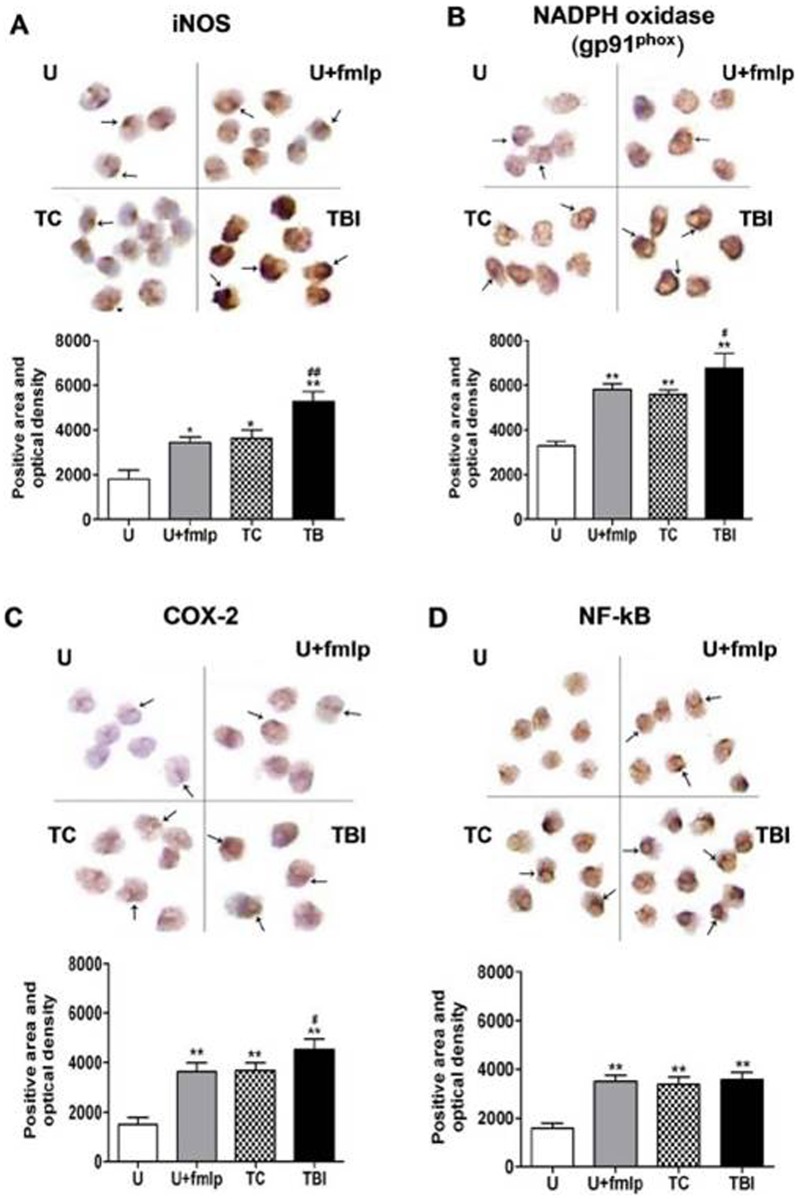
Expression of iNOS, NF-kB, COX-2 and NADPH oxidase (gp91phox) in leukocytes on blood smears.From uninjured (U), uninjured with fMLP activation (U+fMLP) and trauma controls (TC) and traumatic brain injury (TBI) subjects, expression of iNOS, NF-κB, COX-2 and NADPH oxidase (gp91phox) in leukocytes subjects at 24 h after injury are determined with immunostaining on blood smears. Blood smears were immunostained for the NF-κB (nucleus) and the oxidative enzymes (cytoplasm). Photomicrographs at the top of A-D are typical examples of immunostained cells amplified 400 times and the arrows indicate the positive expression. Blood smears were analyzed by Image-Pro plus 6.0 software to obtain a measure of positive area and optical density. Bar graphs in lower panels of A–D depict mean positive area and optical density ± SE for each group (n = 5 subjects/group). After treatment of blood samples with fMLP and in TC and TBI subjects, expression of iNOS, NF-kB, COX-2 and NADPH oxidase (gp91phox) all increased significantly when compared to values from uninjured subjects. iNOS, COX-2 and NADPH oxidase (gp91phox) expression was greater after TBI than in trauma control subjects. **P<0.01; *P<0.05, significantly different from uninjured by Fisher’s protected t tests. ##P<0.01; #P<0.05, significantly different from trauma controls by Fisher’s protected t tests.